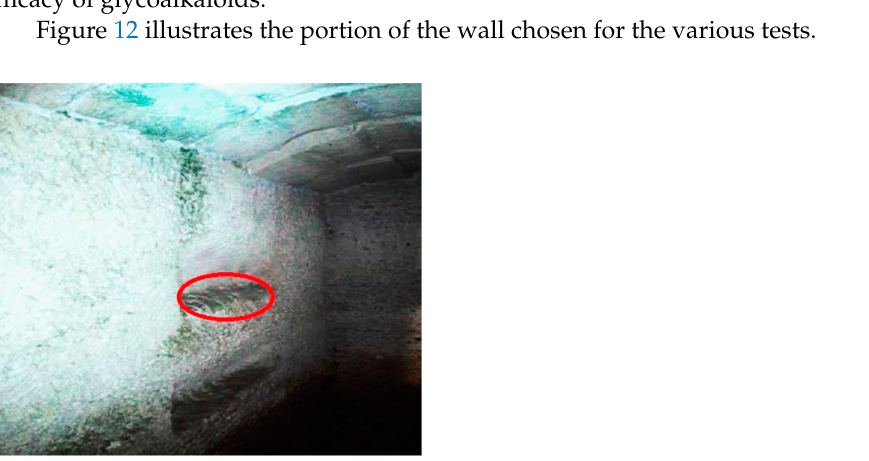
Figure 12. Study area with bio-patina in the hypogeum of San Pietro Barisano church. During the cleaning test, the microclimate conditions of the wall surface portion sampled were locally ranging between 89–92% humidity and 11–16 °C temperature.